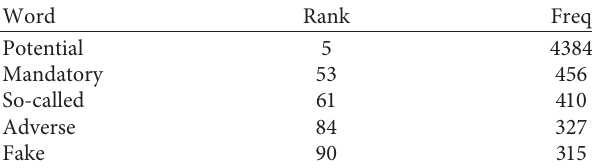
Table 1: Positive collocation of the word vaccine . Table 2: Negative collocation of the word